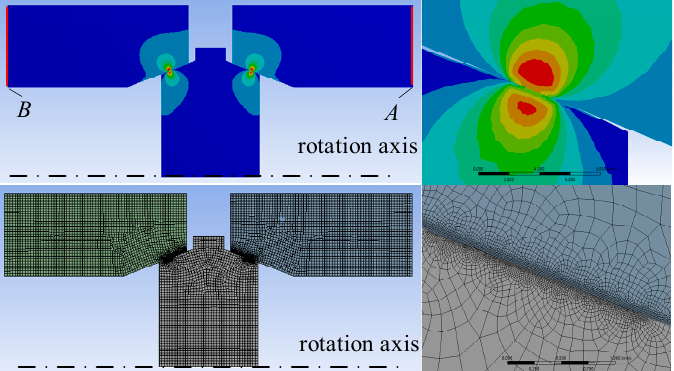
Figure 8. Contact stress distribution and divisions of mesh.